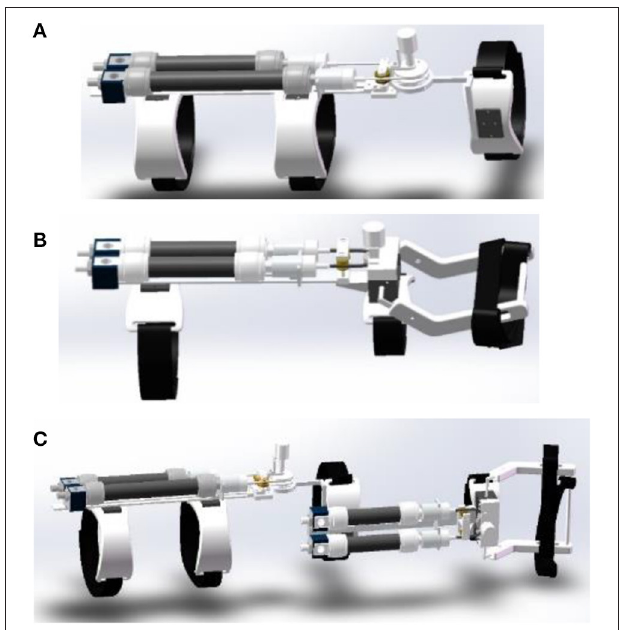
FIGURE 1 | The designed soft modular elbow–wrist rehabilitation exoskeleton driven by PAMs, (A) the elbow module, (B) the wrist module, and (C) the reconfigured with modular parts.